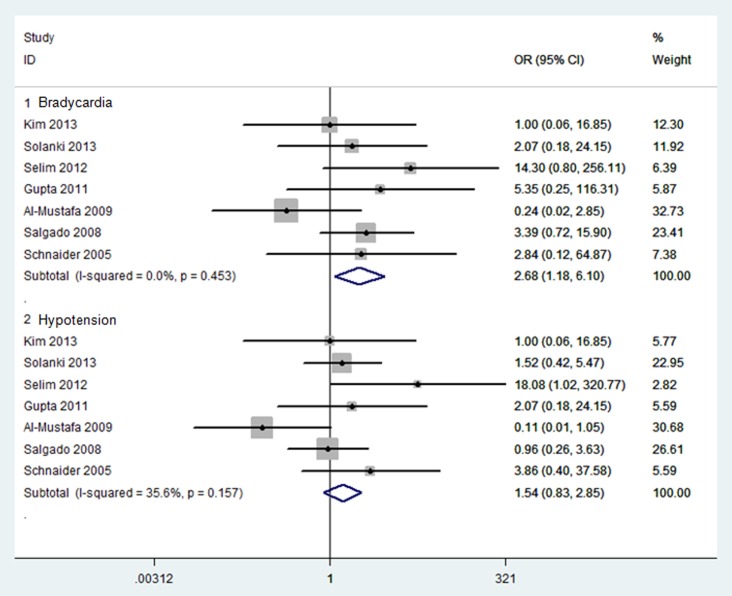
Forest plot: Primary adverse events: bradycardia and hypotension.